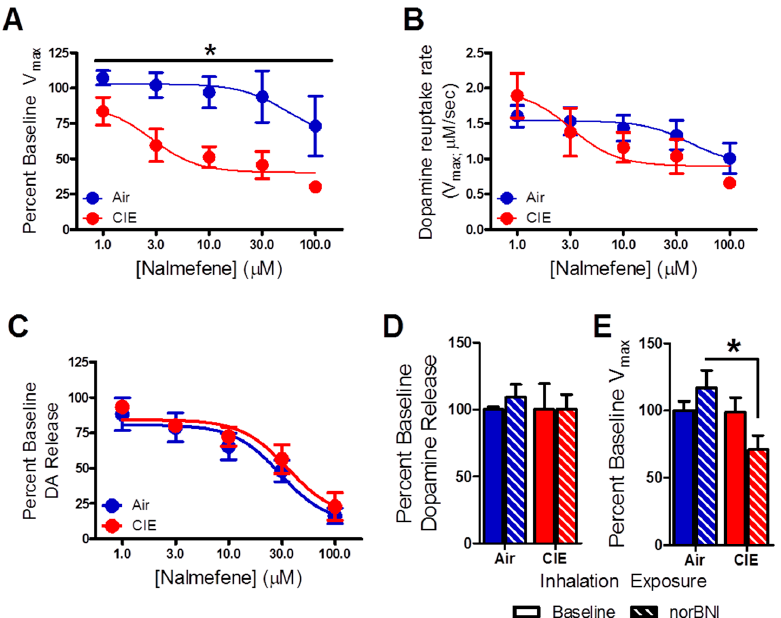
Figure 2. Nalmefene attenuates uptake rates in brain slices from CIE-exposed mice. ( A ) Nalmefene concentration-dependently attenuated the maximal rate of uptake rate ( V max ) in both groups, although this effect was greater in brain slices from CIE exposed animals compared to air-exposed mice; ( B ) nalmefene reduced the uptake rate in CIE-exposed animals to a level comparable to that found in air-exposed mice even; ( C ) nalmefene concentration-dependently decreased dopamine release similarly in the inhalation groups; ( D ) the KOR antagonist, norbinaltorphimine (norBNI) did not alter dopamine release in either inhalation group; ( E ) NorBNI reduced uptake rates in brain slices from CIE-exposed mice compared to controls. * p < 0.05 (CIE: chronic intermittent ethanol). 2.3. Nalmefene Reversed the Dopamine-Decreasing Effects of U50,488 in CIE-Exposed Mice Representative traces showing the effects of 0.3 µM U50,488 on dopamine release and uptake (Figure 3A, blue, air; Figure 3B, red, CIE) and 10.0 µM nalmefene reversal (black line, overlaid). The effects of CIE on KOR function were examined with increasing concentrations of U50,488. A RM